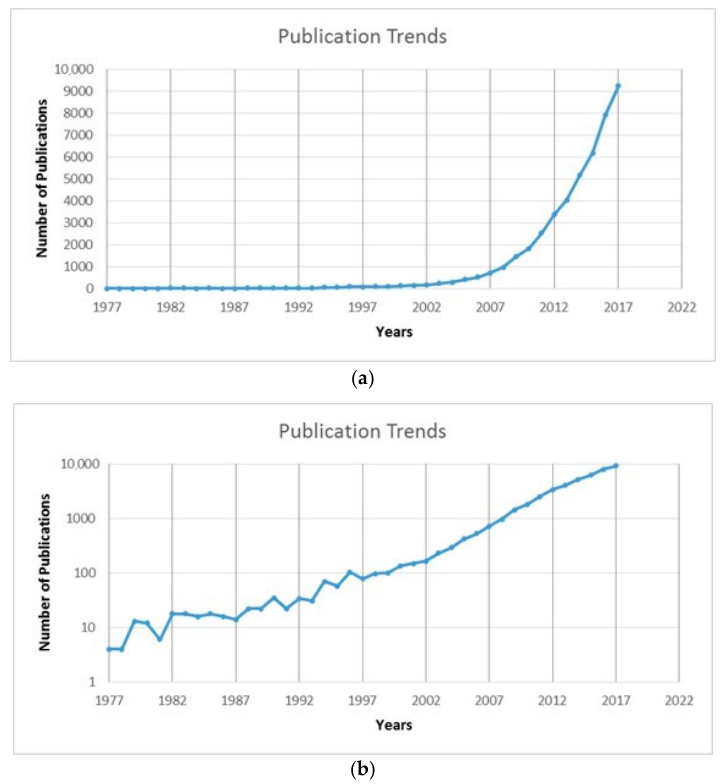
Figure 3. ( a ) Trend in renewable energy in urban areas publications during the period of 1977–2017. ( b ) Trend in renewable energy in urban areas publications showing the data with a logarithmic scale along the y -axis.